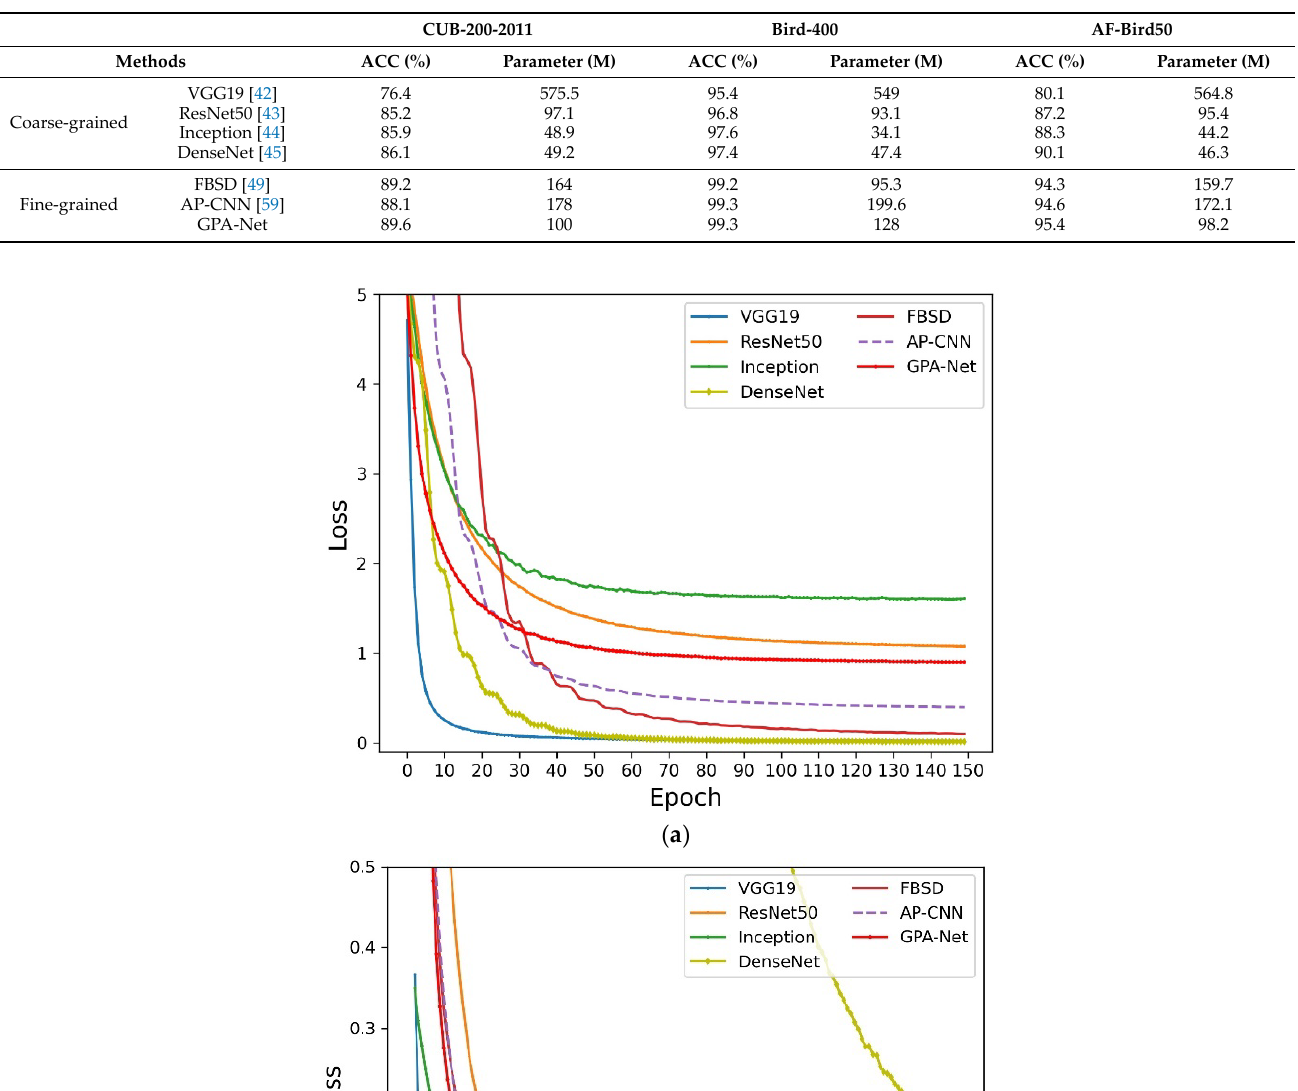
Table 1. The classification results of three datasets.